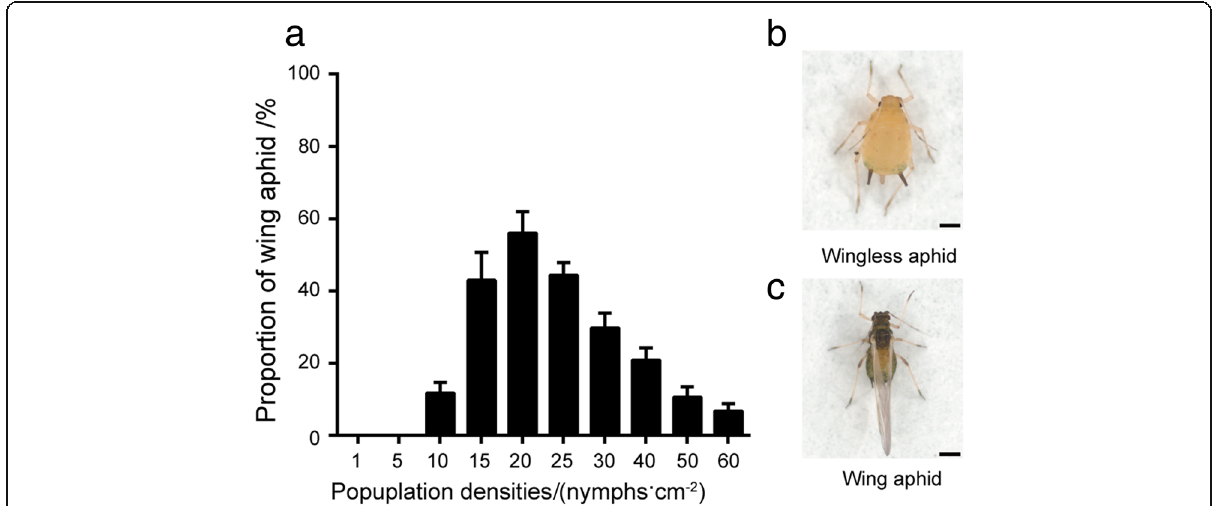
Fig. 1 Effects of postnatal crowding on wing morph switch in Aphis gossypii. a Proportion of wing cotton aphids induced by postnatal crowding